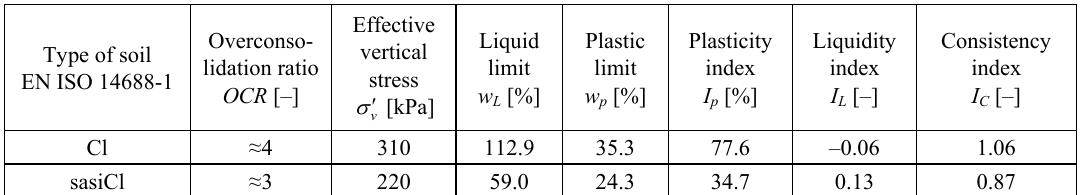
Table 1. Index properties of the test